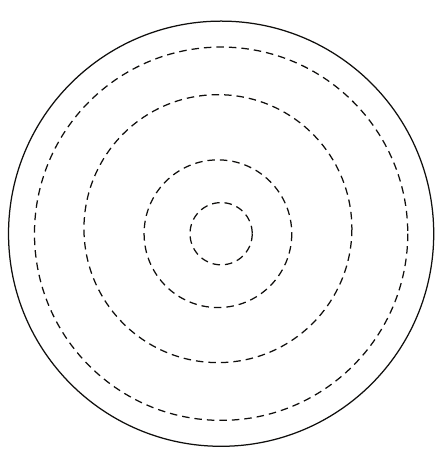
Figure 4: Iso-contours when source is at the center of a